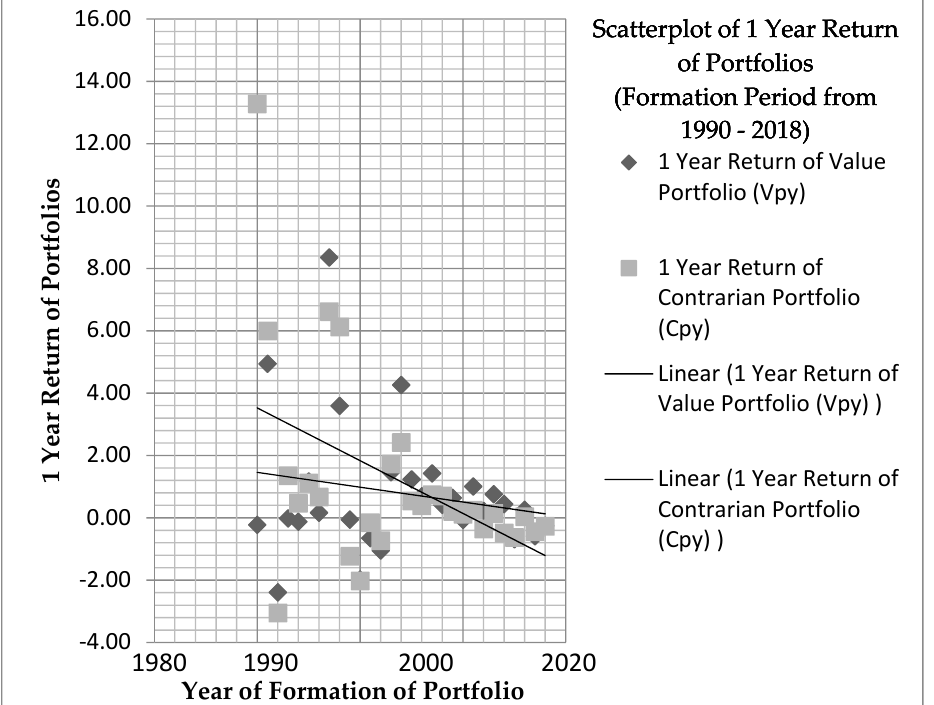
Figure 4. Scatterplot (t + 1).